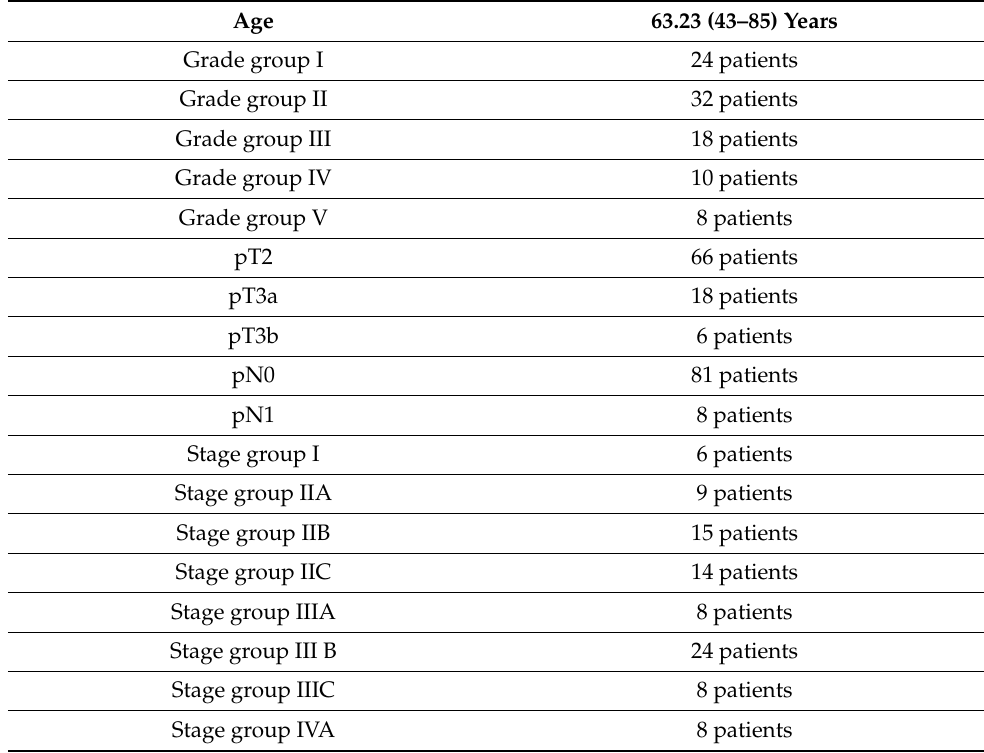
Table 1. Clinical characteristics of